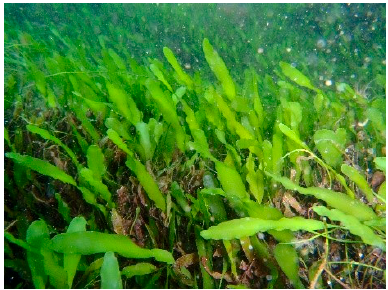
Figure 1. Underwater photo of Caulerpa prolifera